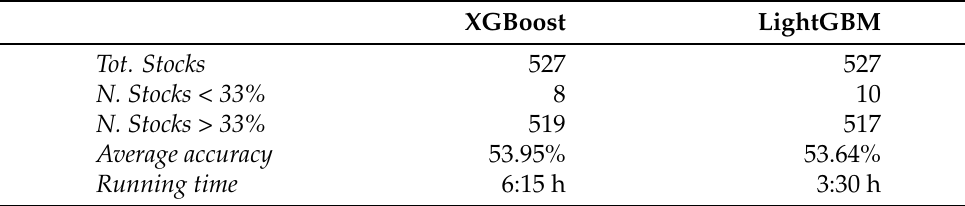
Table 3. Results of XGBoost and LightGBM over the entire